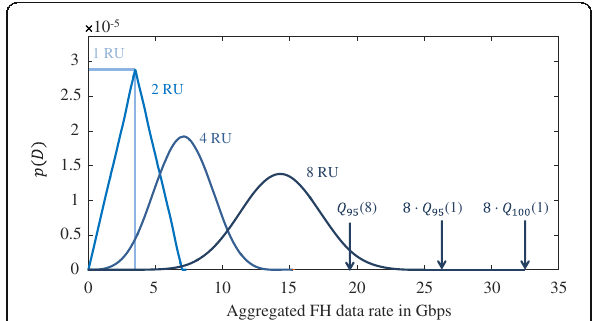
Fig. 6 Convolution of PDFs leading to multiplexing gains for split B and 2-GHz carrier